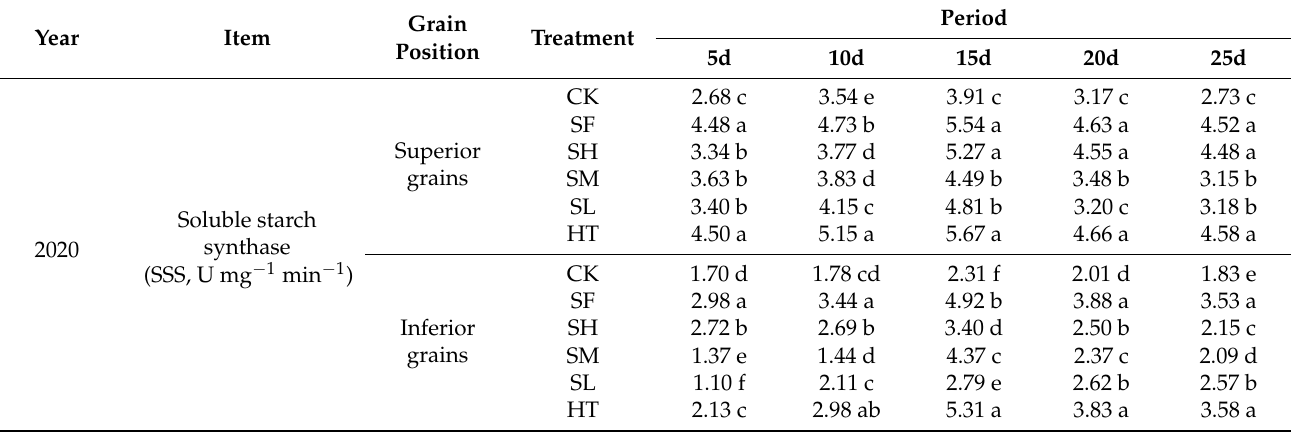
Table 3. Effect of rice straw combined with inorganic fertilizer on starch synthase